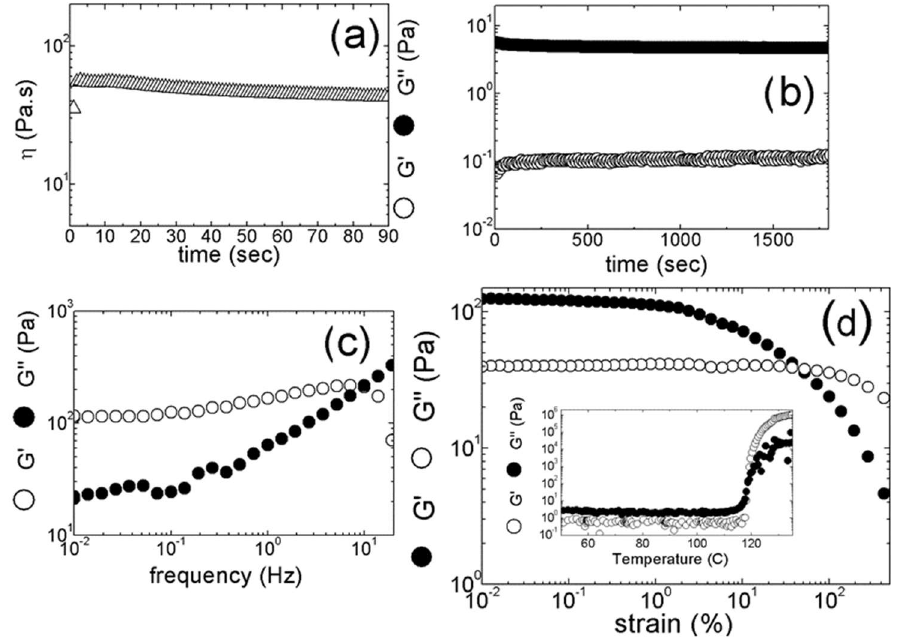
Figure 1. Rheological protocol: ( a ) time evolution of the shear viscosity response to the application of a steady shear rate of 1 s −1 for a resin containing 0.1 wt.% SWCNT; ( b ) time evolution of the shear storage (G’) and loss (G’’) moduli during the structural recovery of a resin containing 0.08 wt.% SWCNT, following the cessation of the steady shear applied in ( a ); ( c ) mechanical spectrum of a resin containing 0.1 wt.% SWCNT, measured after achieving structural equilibrium as shown in ( b ); ( d ) strain dependence of storage (G’) and loss (G’’) moduli of a resin with 0.1 wt.% SWCNT; inset in ( d ) is the curing at 5 °C/min of the neat resin.